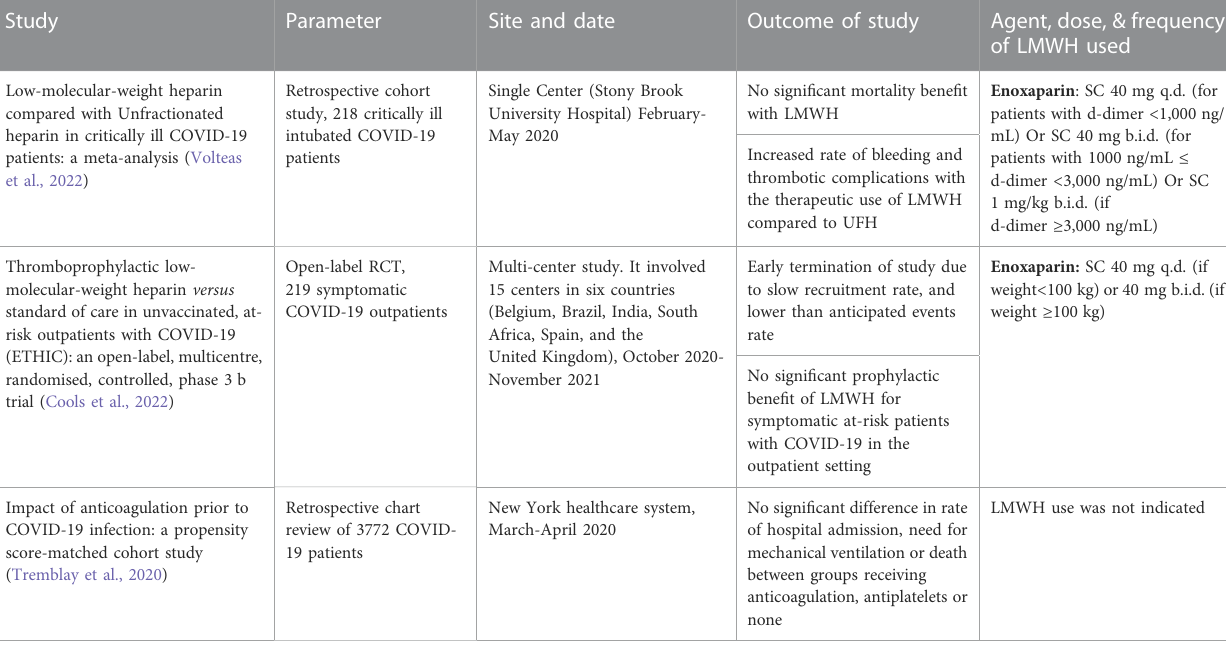
TABLE 2 The high impact studies tackling the negative outcomes of using LMWH as anticoagulant in COVID-19.